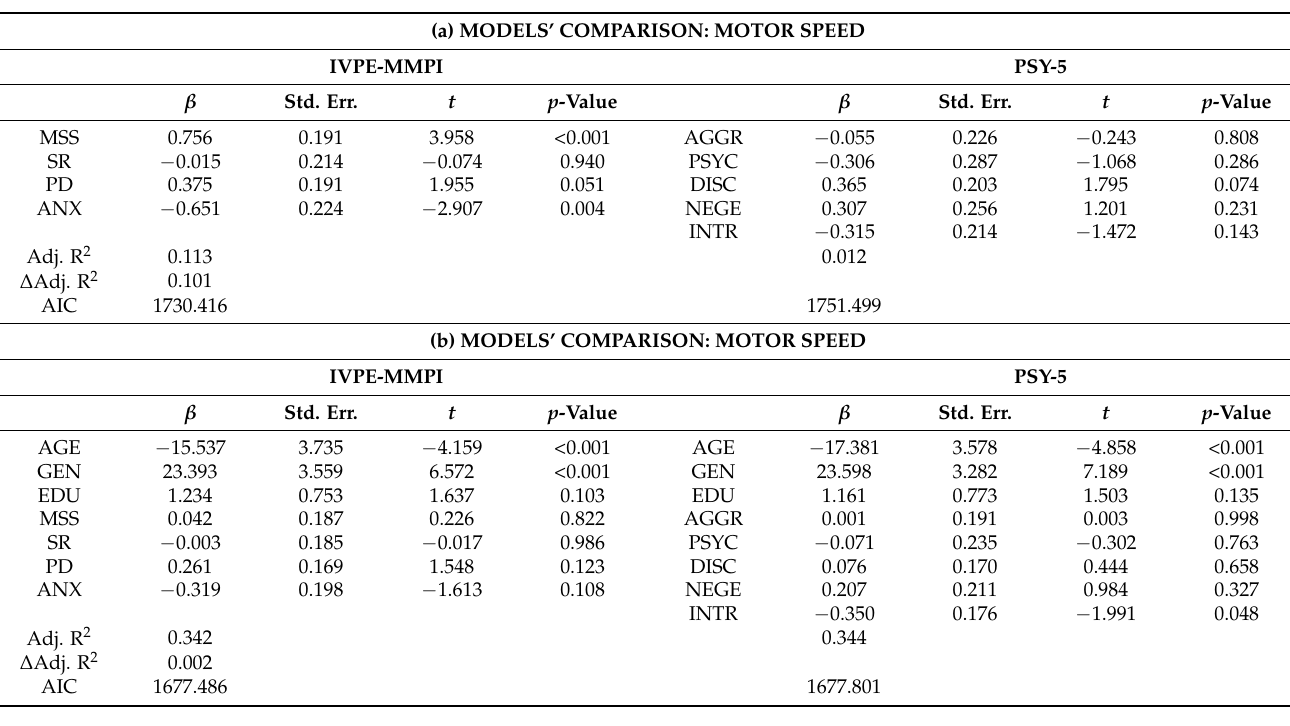
Table 3. Standardized beta coefficients. Standard errors and significance levels for predictors of the motor speed (MS) variable. Adjusted R 2 and Akaike Information Criterion (AIC) are also reported. Comparisons between models are presented uncontrolling for demographics ( a ) and considering their contribution ( b ).